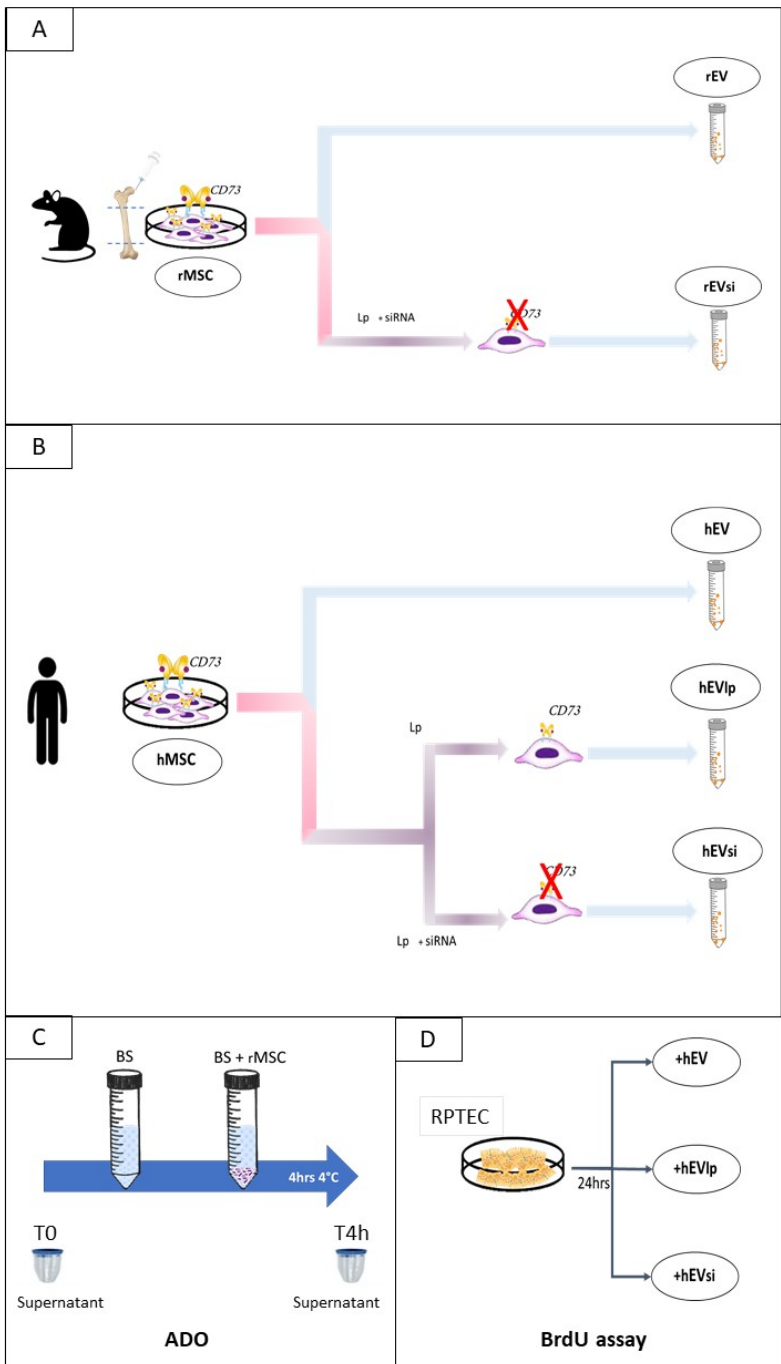
Figure 9. In vitro experimental design. ( A ) Isolation of extracellular vesicles (EVs) from rat mesenchymal stromal cells (rMSCs), naïve cells (rEVs), and CD73-silenced cells (rEVsi). ( B ) Isolation of EVs from human MSCs (hMSCs), naïve hMSCs (hEVs), hMSCs transfected with lipofectamine (lp; hEVlp), and CD73-silenced hMSCs (hEVsi). ( C ) Naïve rMSCs were incubated in Belzer solution (BS) under hypothermic conditions. At the start (T0) and after 4 hours (“h”) (Tend) of incubation, the supernatants of BS and BS + rMSCs were collected to measure the adenosine (ADO) levels. ( D ) Human primary renal proximal tubular epithelial cells (RPTECs) were stimulated with EVs derived from naïve hMSCs (hEVs), lp-transfected hMSCs (hEVlp), and CD73-silenced hMSCs (hEVsi). After 24 h, cell proliferation was evaluated using the bromodeoxyuridine (BrdU) assay.